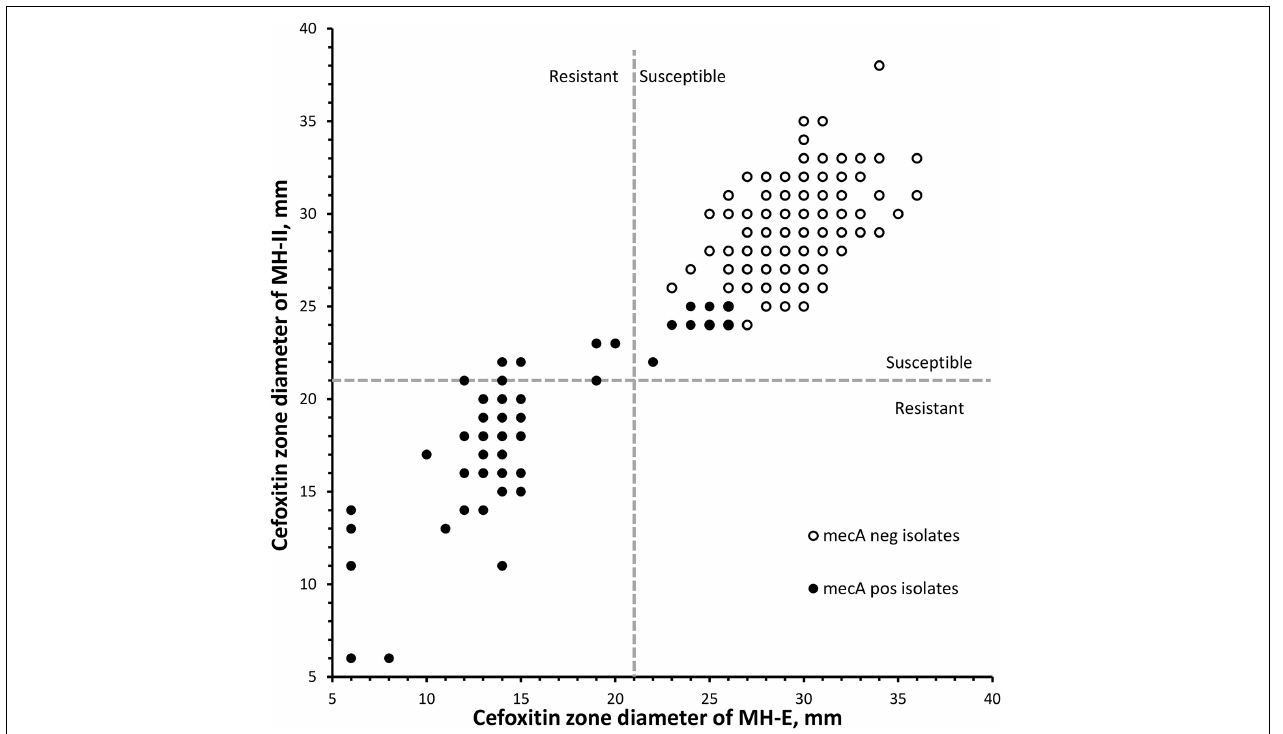
FIGURE 1 | Scatterplot of cefoxitin inhibition zone diameters of 300 Staphylococcus lugdunensis isolates using two brands of Muller-Hinton agars. Dotted lines indicated the cefoxitin breakpoints for S. aureus / S. lugdunensis according to the CLSI M100-2020. MH-E, Muller-Hinton E agar from bioMérieux and MH-II, Muller-Hinton II agar from Becton Dickinson.